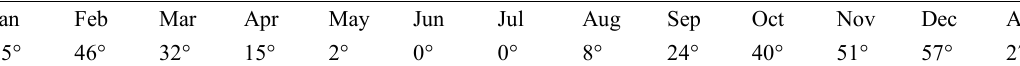
Table 9. Monthly optimal tilt angle using MATLAB for New Delhi.